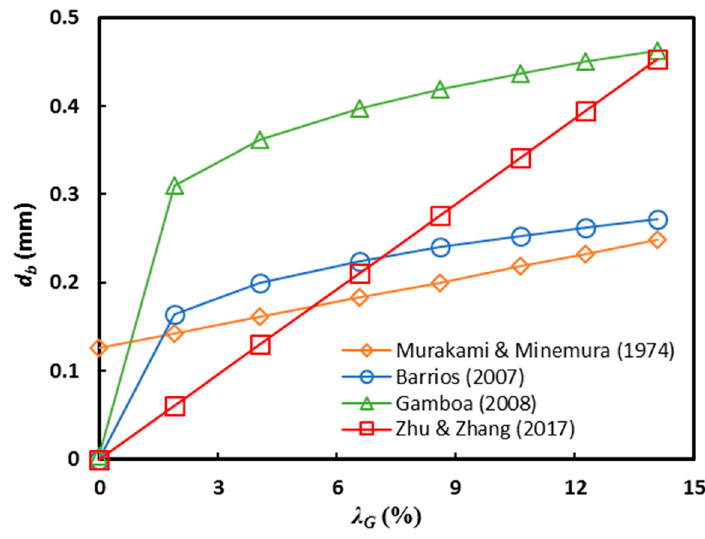
Figure 20. Comparison of bubble size prediction models.